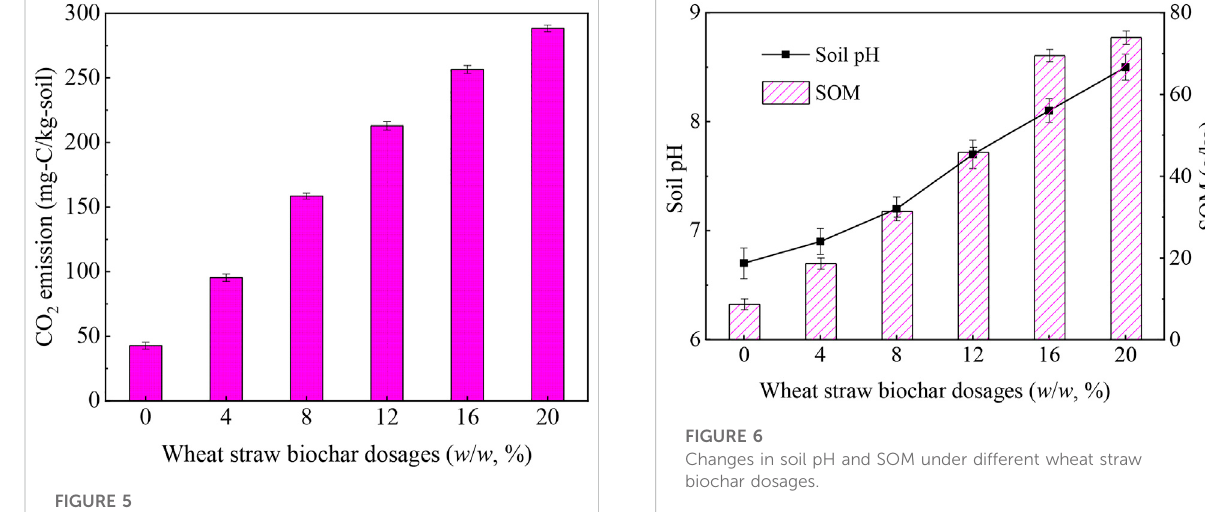
FIGURE 5 CO 2 emission under different wheat straw biochar dosages.